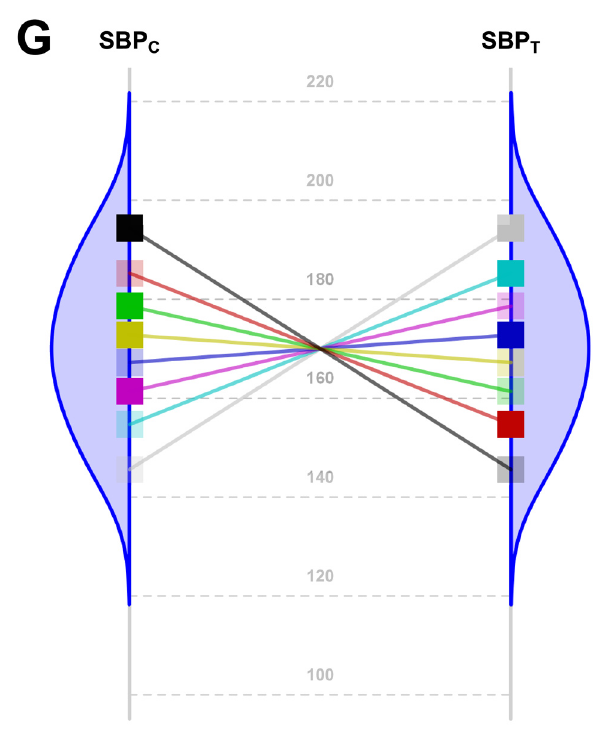
Figure 4. Scenario representing a fictional trial with 8 participants and having homoscedasticity but a non-constant effect. SBP potential values of each patient in both groups (C: control; T: treated) under a highly hypothetical scenario: the treatment effect has no value if systematically applied to the whole population; but if n-of-1 trials could be performed in this situation, the best treatment strategy would be chosen for each patient and the overall health of the population would be